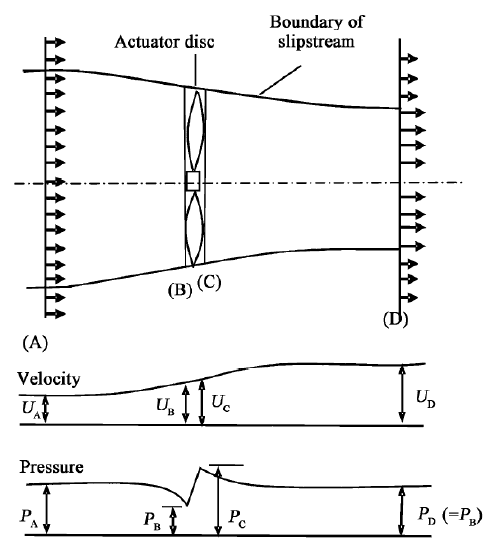
Figure 6. Diagram of efflux velocity derivation, where are zone ( A ) the far upstream, zone ( B ) the immediate upstream, zone ( C ) the immediate downstream, and zone ( D ) the far downstream [15]. Equation (4) and Equation (5) can be